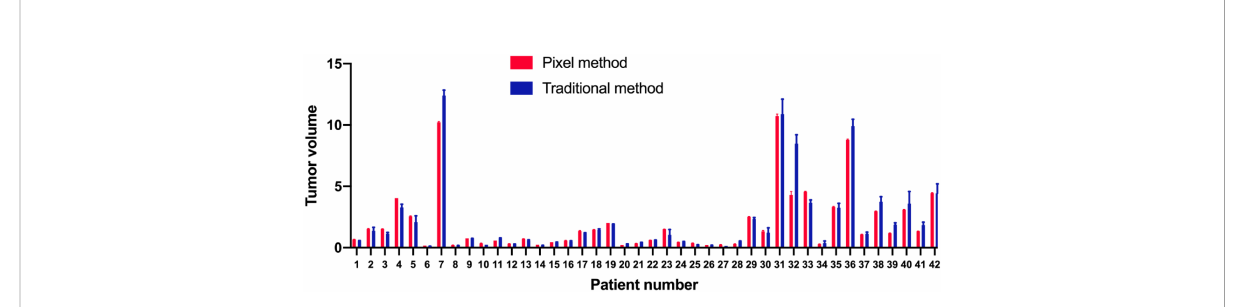
FIGURE 3 Means and standard deviations of each tumor volume as measured by pixel (red) and traditional (blue)